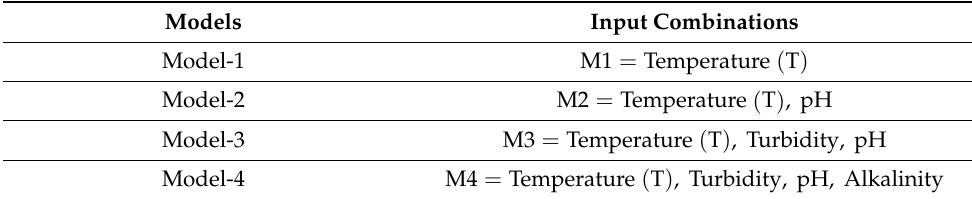
Table 3. The input combinations to estimate DO and BOD 5 WQ variables.